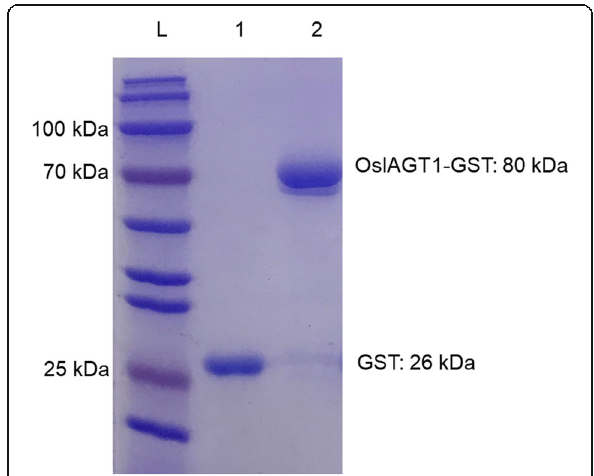
Fig. 2 SDS-PAGE analysis of the recombinant GST-OsIAGT1 fusion protein. L, protein molecular weight ladder; 1, GST-tag protein; 2, OsIAGT1 fusion protein